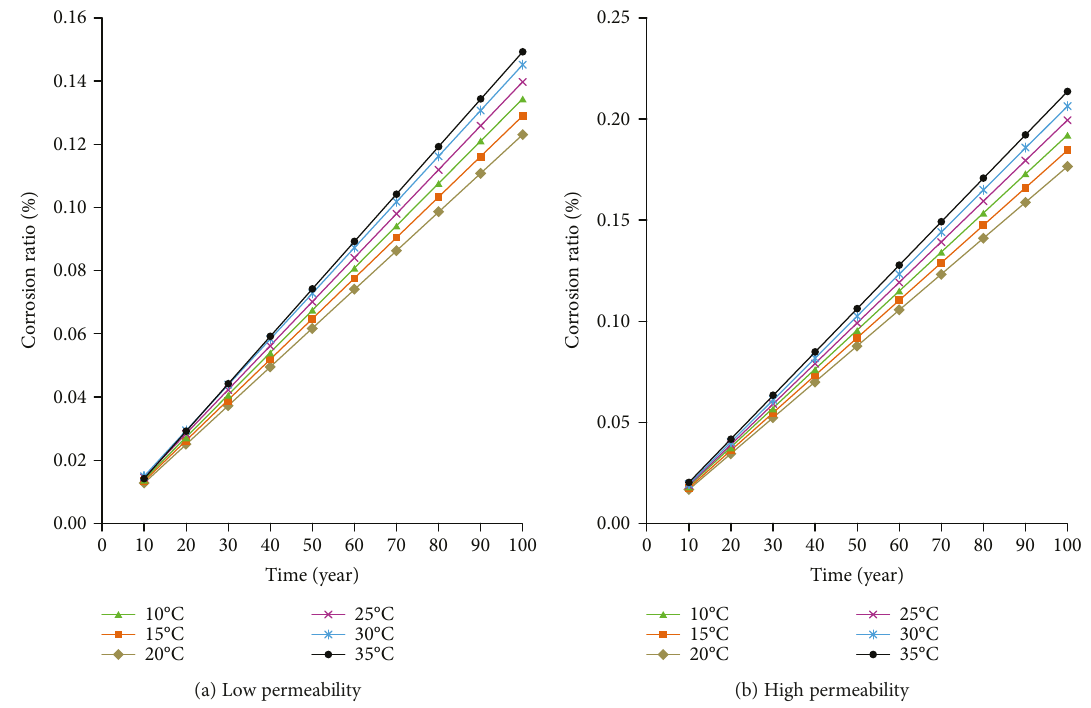
Figure 17: The corrosion ratio of the fi ssure under weak hydrodynamic conditions over